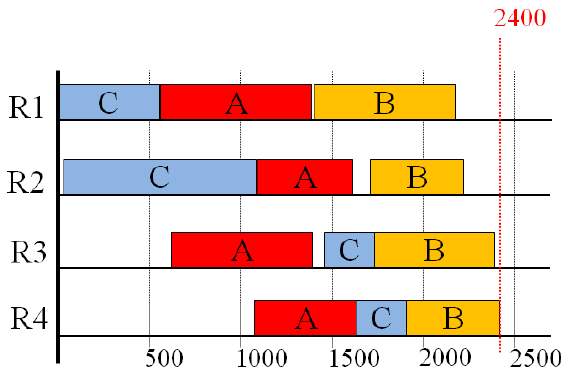
Fig. 5. Gantt chart for the proposed IPMPS solution (55A, 51B and 55C).